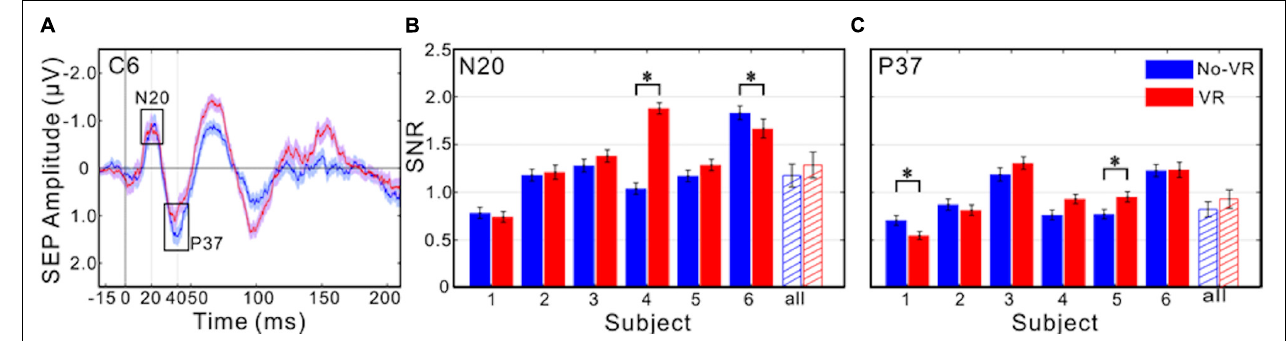
FIGURE 7 | Comparison of SEPs with and without HMD. (A) Median SEPs across 500 epochs from the response period ( − 20 to +210 ms relative to stimulation onset), example shown for contact C6 from S1, for VR (with HMD, red color) and No-VR conditions (without HMD, blue color), separately. Early components (N20 and P37) are marked with black boxes. Red and blue shadow around curves indicated the standard error across 500 epochs for each time point. To improve visibility, a 10 Hz high-pass (Butterworth Filter of third order) filter was applied on the plot data. (B,C) Median signal-to-noise ratio (SNR) from the two early response components ( B for N20 and C for P37), for each subject separately (errorbars indicate the standard error across 500 epochs), and median across subjects (errorbars indicate the standard error across subjects). ∗ Indicate significant difference between the VR and No-VR conditions (Wilcoxon rank-sum test at q <